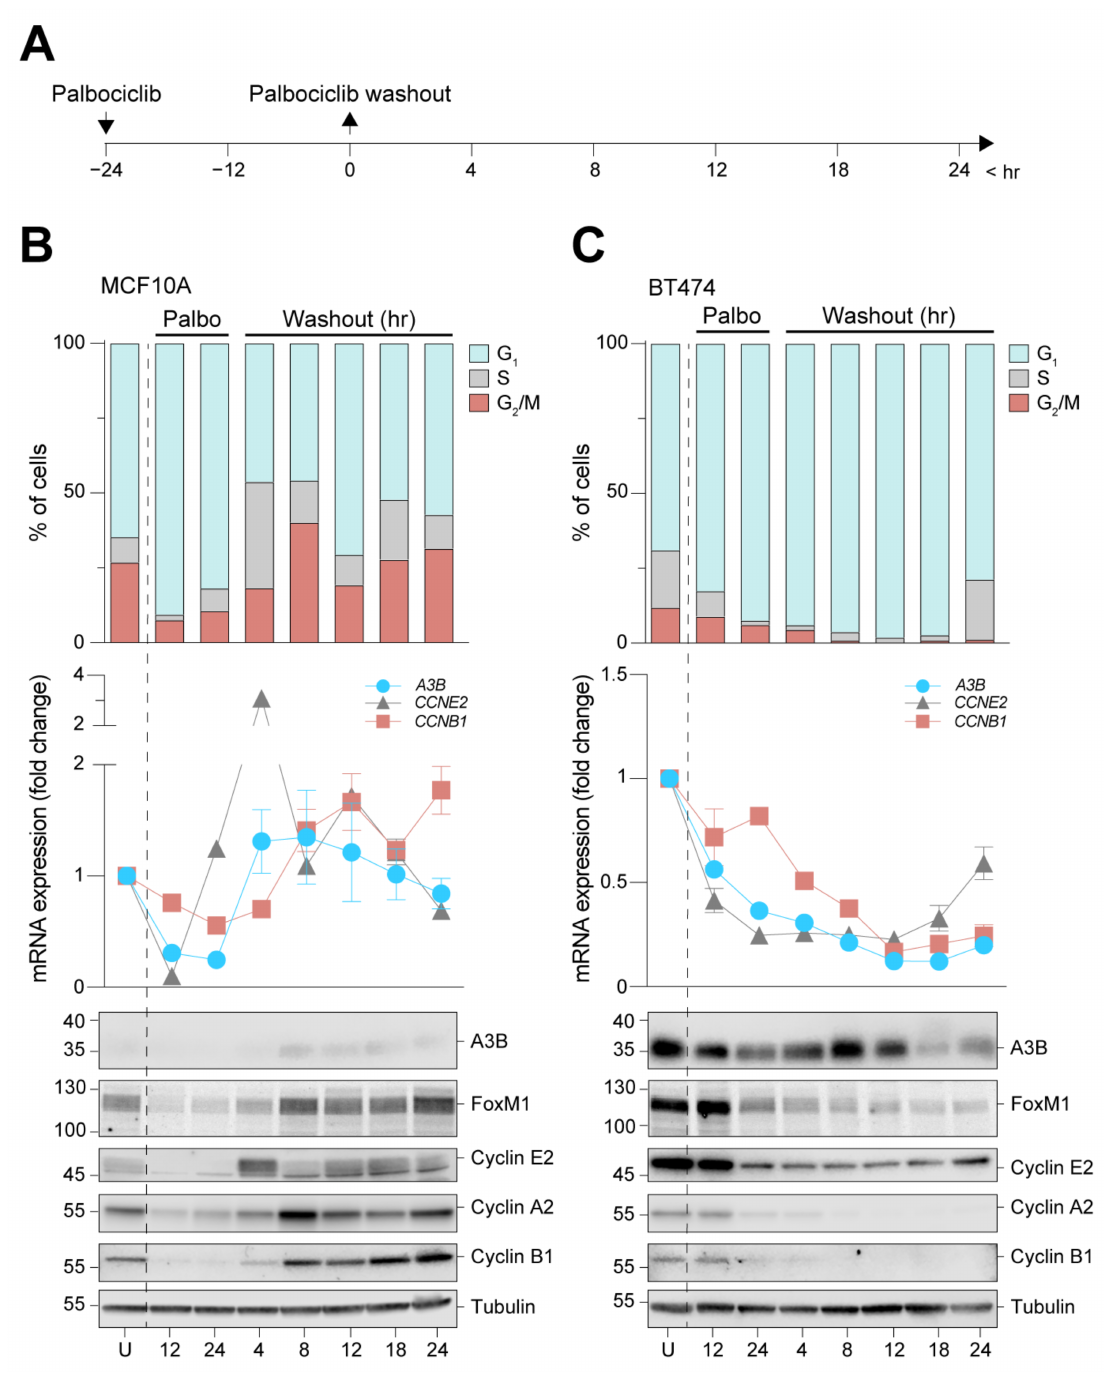
Figure 3. A3B is repressed during G 0 /early G 1 arrest in normal-like MCF10A cells and A3B-high BT474 cells. ( A ) Palbociclib arrests MCF10A and BT474 cells in G 0 /early G 1 by direct interference with the RB/E2F pathway. Cells were treated for 24 h to induce growth arrest, followed by washout and subsequent sampling. ( B , C ) Cell cycle progression (top panels) and RT-qPCR and immunoblot analysis (center and bottom panels, respectively) of A3B, Cyclin E2, and Cyclin B1 during and after palbociclib-induced growth arrest of MCF10A and B474 cells. For immunoblots, samples of both cell lines were loaded on the same gel, but data are depicted separately here due to image intensity adjustments required for visualization of A3B in each cell line. U = unsynchronized. Error bar represents SD. Data represent n = 4 independent